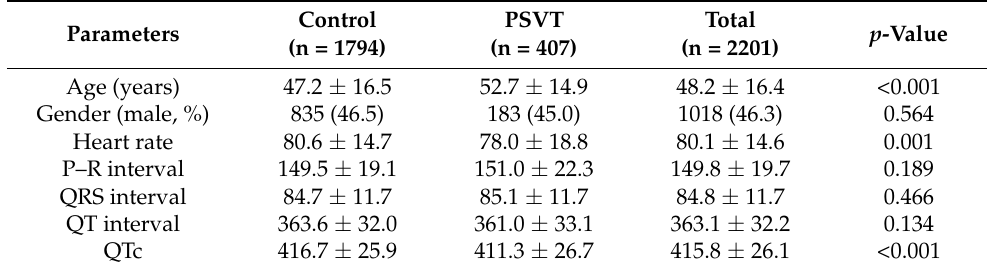
Table 1. Baseline characteristics of patients and ECGs.